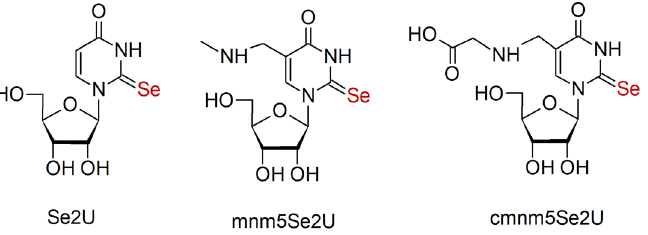
Figure 1. The structures of 2-selenouridine Se2U and its 5-substituted counterparts mnmSe2U and cmnmSe2U present in wobble position of bacterial tRNAs.